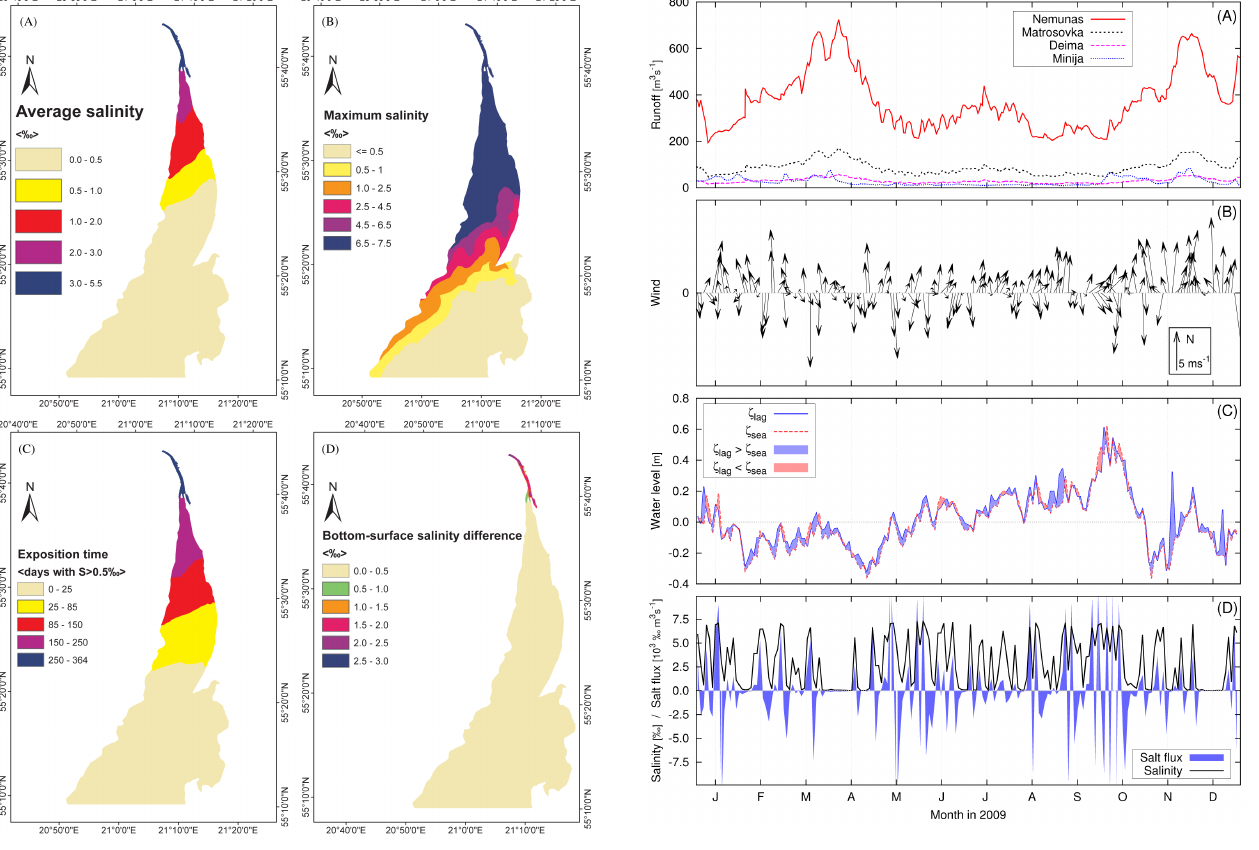
Fig. 4. Spatial distribution in the northern part of the Curonian Lagoon of (A) annual average of vertically-averaged salinity, (B) yearly maximum of vertically-averaged salinity, (C) number of days per year when vertically-averaged salinity stays greater than 0.5‰, (D) difference between annual average of surface and near bottom layer salinity.